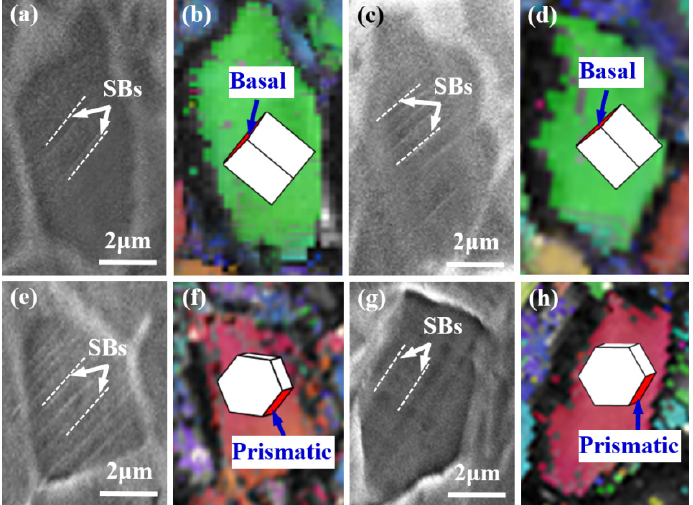
Figure 14. Examples of identification of activated slip systems on the α p phase in bimodal microstructure; ( a , b ) a basal slip activates (SF = 0.38) in the α p phase; ( c , d ) a basal slip activates (SF = 0.37) in the α p phase; ( e , f ) a prismatic slip activates (SF = 0.45) in the α p phase; ( g , h ) a prismatic slip activates (SF = 0.46) in the α p phase.